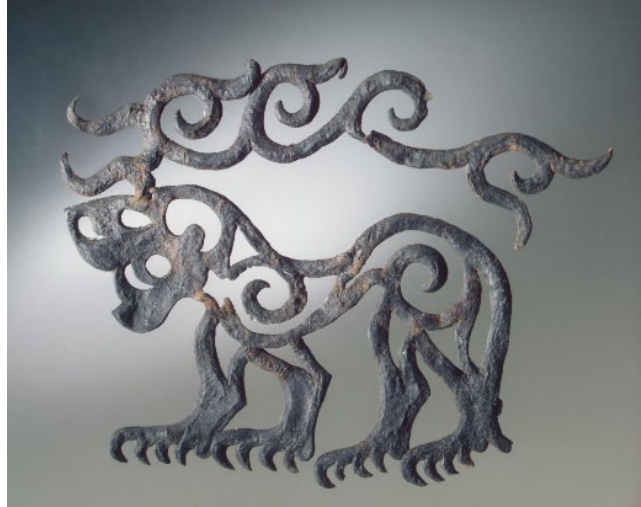
Figure 14. Applique of tiger with antlers (SHM inv. no. 2179 ‐ 912); leather; Kurgan 1, Tuekta, Altai